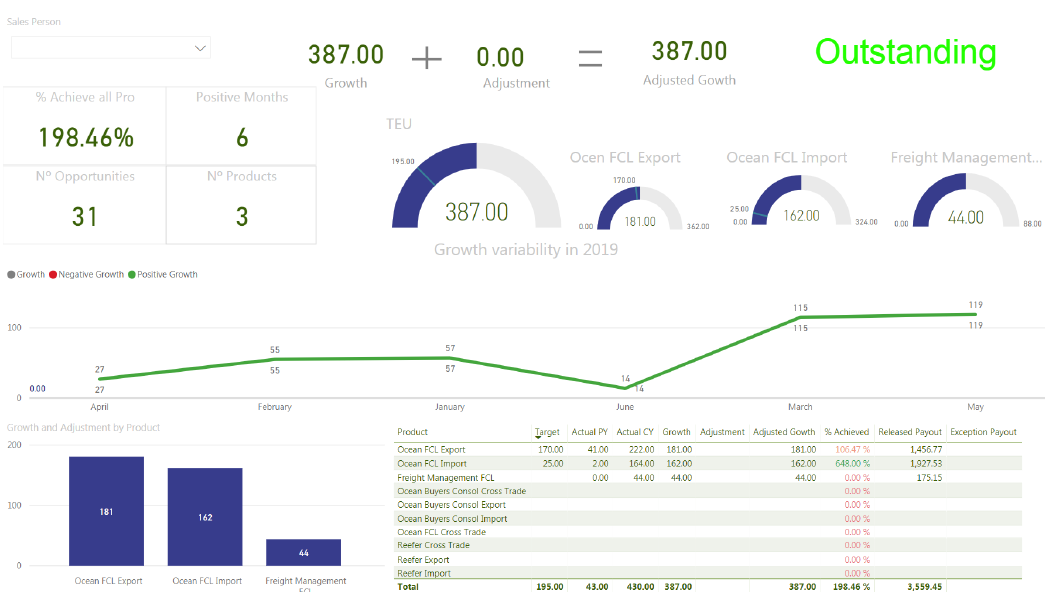
Figure 11. Dashboard for a salesperson classified as